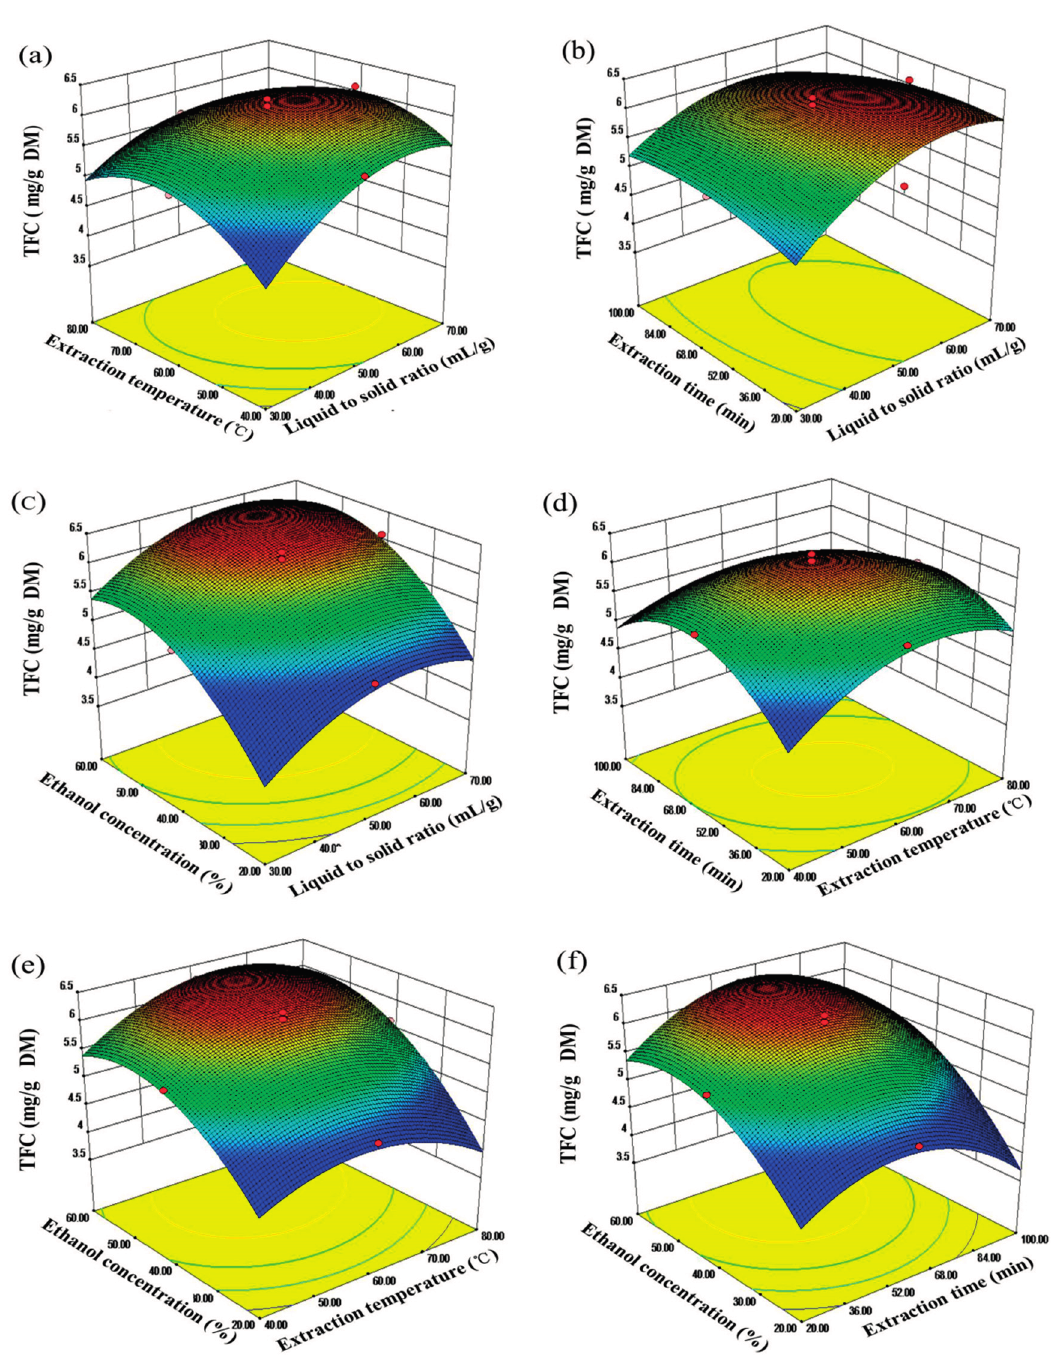
Figure 5. Response surface plots (3D) showing the effects of variables on total flavonoid extraction. ( a ) liquid to solid ratio and temperature; ( b ) liquid to solid ratio and time; ( c ) liquid to solid ratio and Ethanol concentration; ( d ) time and temperature; ( e ) temperature and ethanol concentration; ( f ) time and ethanol